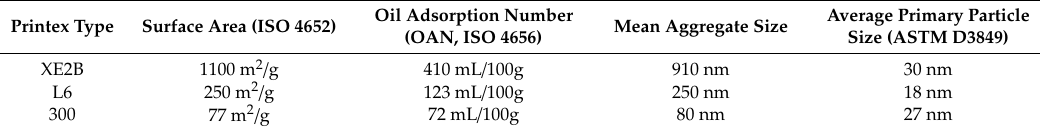
Table 1. Properties of various carbon blacks (data of supplier).